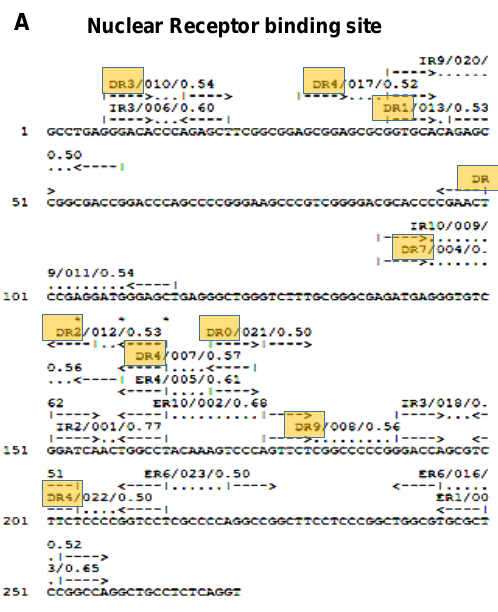
Table 1. DNA-Transcription factor interaction.